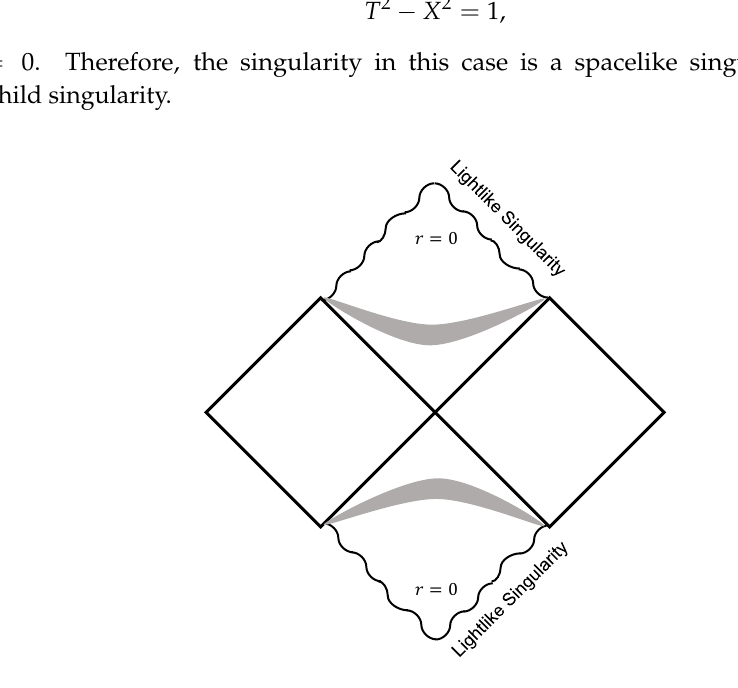
Figure 5. The Penrose diagram of the lightlike singularity in the black hole for δ > 0. The curly lines indicate the lightlike singularities. The shadowed regions refer to the spacetime patches around x i , if we match a Schwarzschild spacetime and the interior spacetime with the non-vanishing mimetic